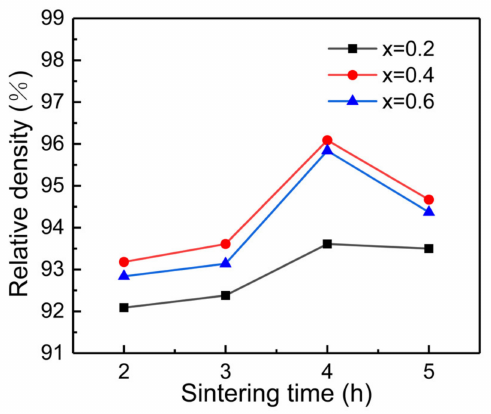
Figure 3. Relative density of LLZN x O (x = 0.2, 0.4, 0.6) ceramics.